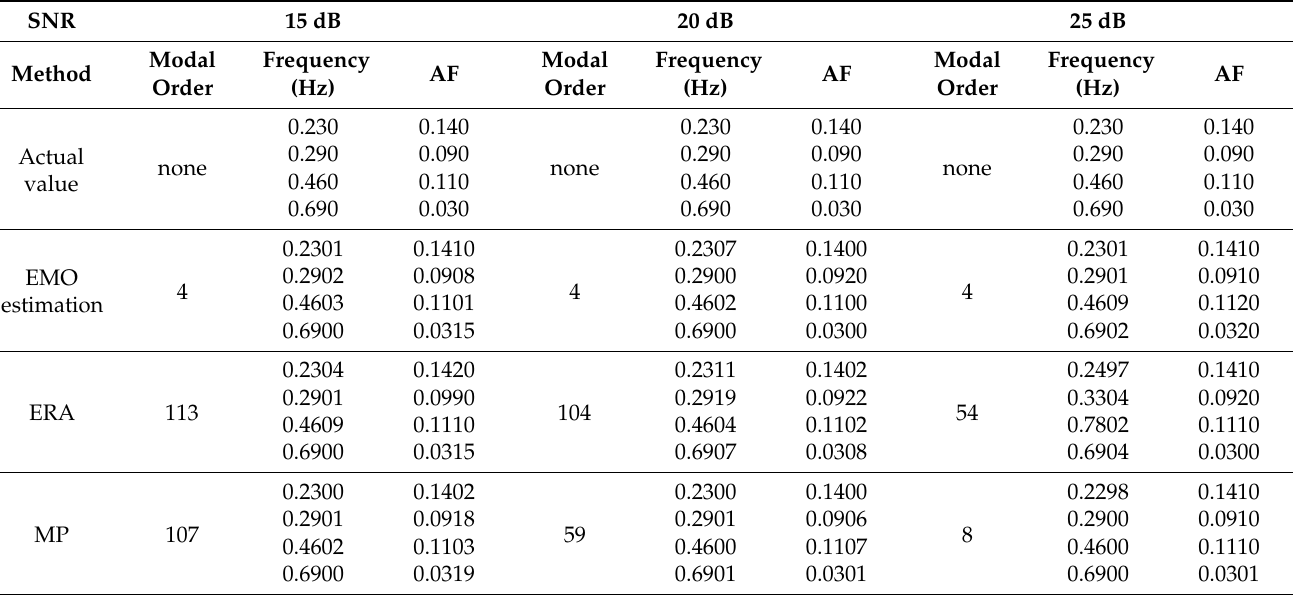
Table 1. Comparison of modal order and modal parameters among the autocorrelation matrix EMO estimation algorithm, MP method, and ERA